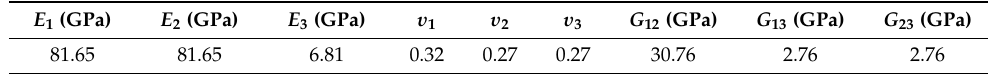
Table 2. Material constants of CFRP laminate.